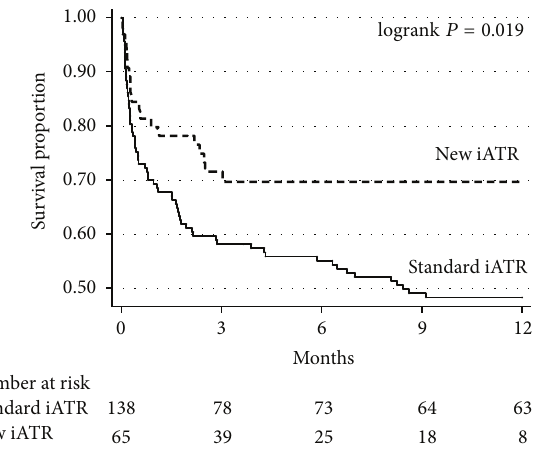
Figure 1: Kaplan-Meier survival estimates by the initial antituber- culous regimen of 203 HIV patients with tuberculous meningitis. iATR, initial antituberculous